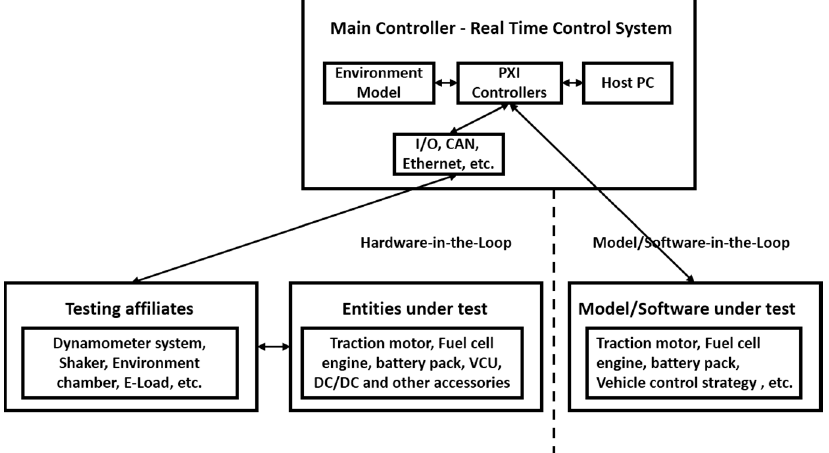
Figure 6. Integrated testing platform.